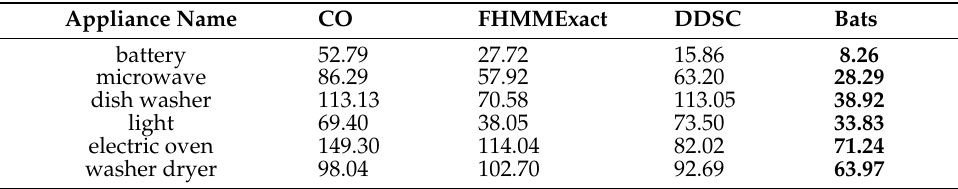
Table 5. MAE in the REDD dataset.